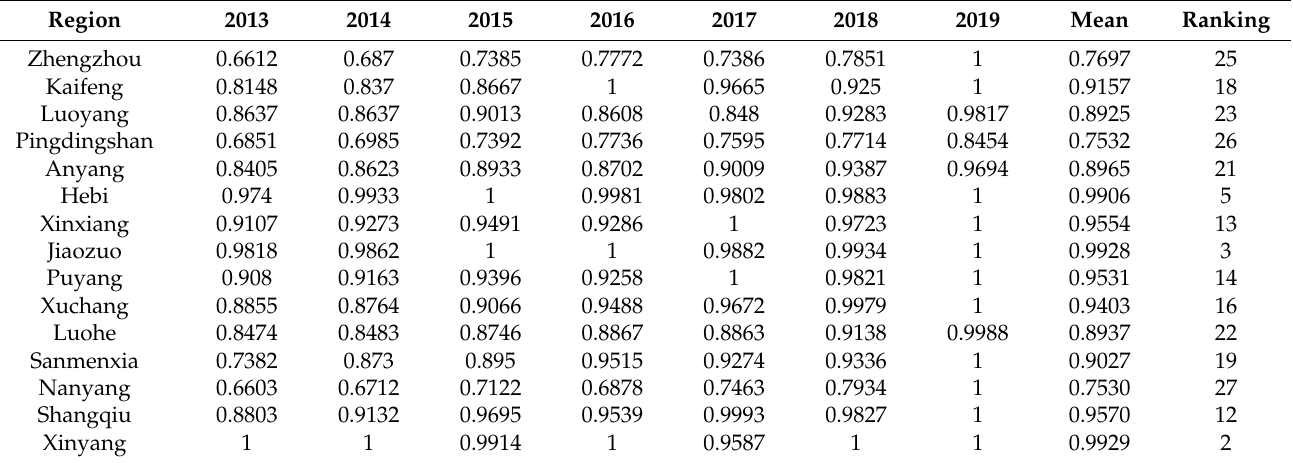
Table 3. Efficiency of the agricultural circular economy in various cities (counties) of Henan Province in 2013–2019 under the BCC